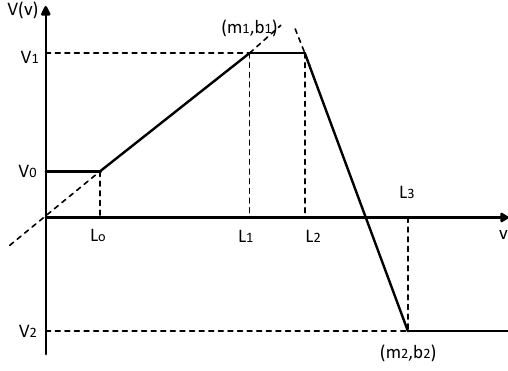
Figure 5. Graphical representation of majority voting scheme classifier.